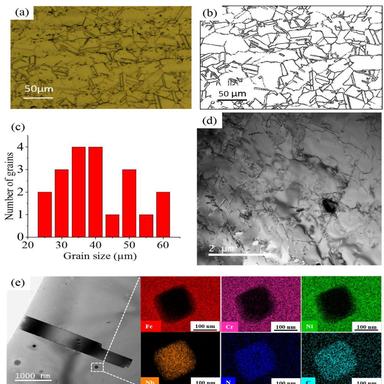
Optical microscopic image (a) and GB traces (b) of as-received alloy 709 microstructure with its grain size distribution (c), TEM imaging of dislocations presence interacting with precipitates, (d) twin boundaries, and pre-existing MX precipitates rich in Nb as shown by EDX maps (e).